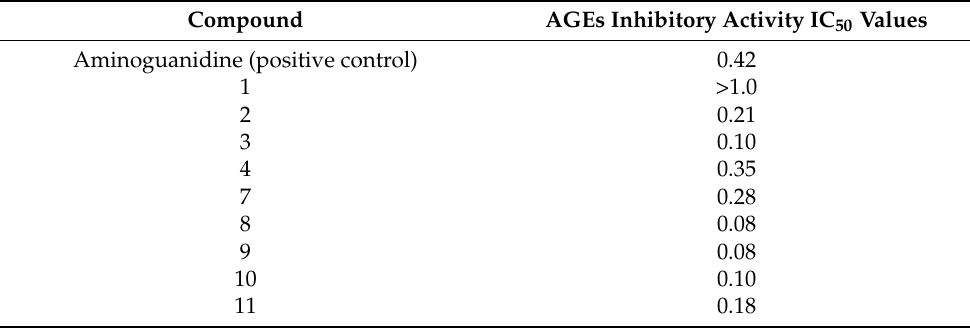
Table 1. IC 50 values of the AGEs inhibitory activity test of the isolated compounds.